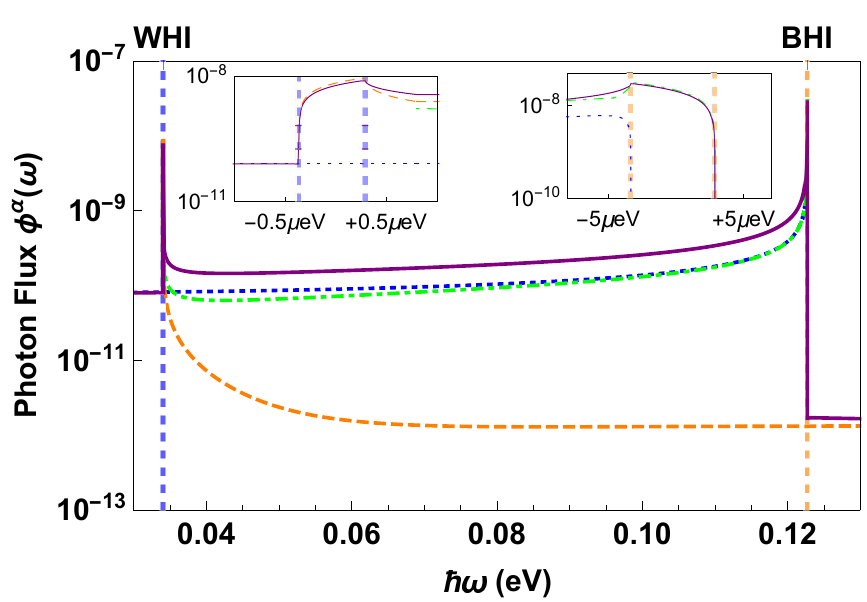
Figure 2: Spectra of photon flux (2) of the optical modes in the moving frame: noL , purple solid line; uoL , blue dotted line; moR , green dot-dashed line; loL , orange dashed line. Insets zoomed-in around the centre frequency of the WHI and BHI.